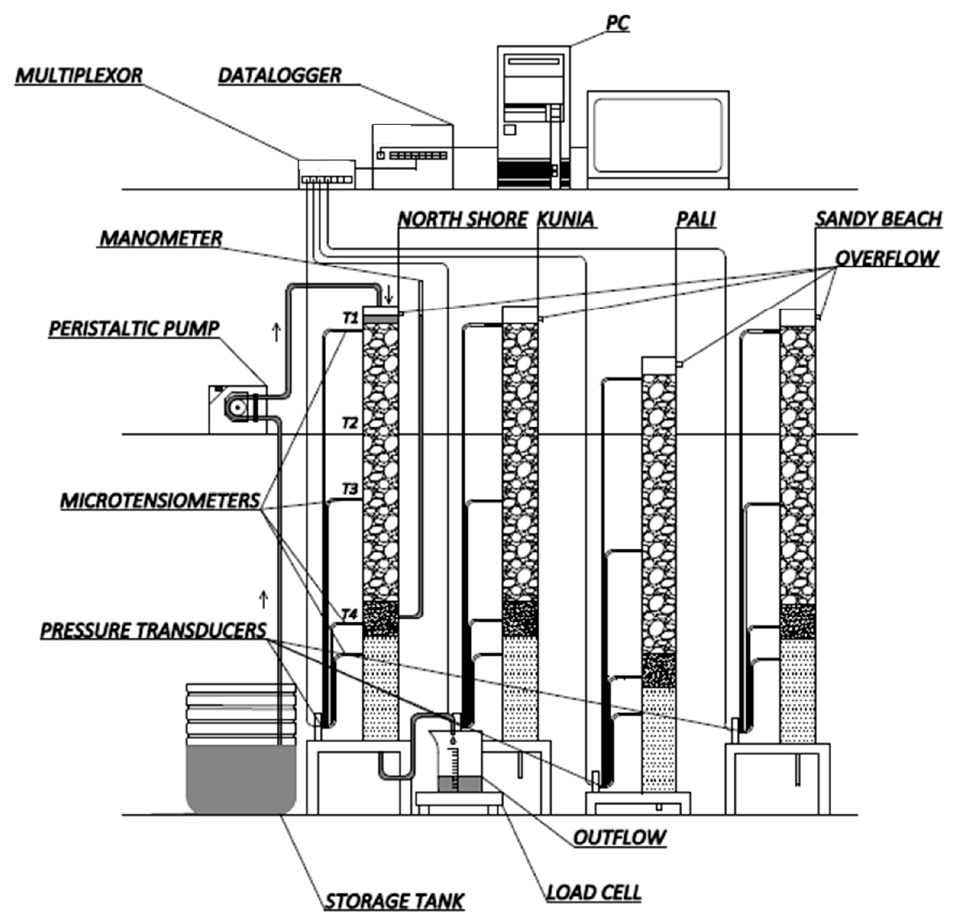
Figure 2. Schematic of the setup used for the intermittent infiltration-outflow experiments on four soil columns including gravel (80 cm), sand (10 cm), and soil (25 cm).